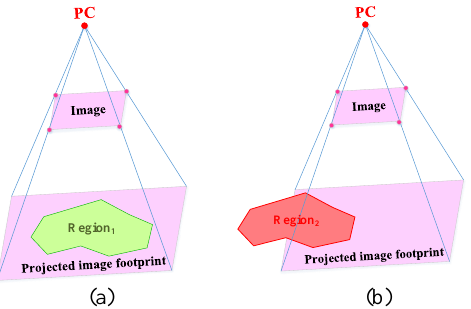
Figure 3. Representation of (a) a fully visible region and (b) a partially visible region in an image